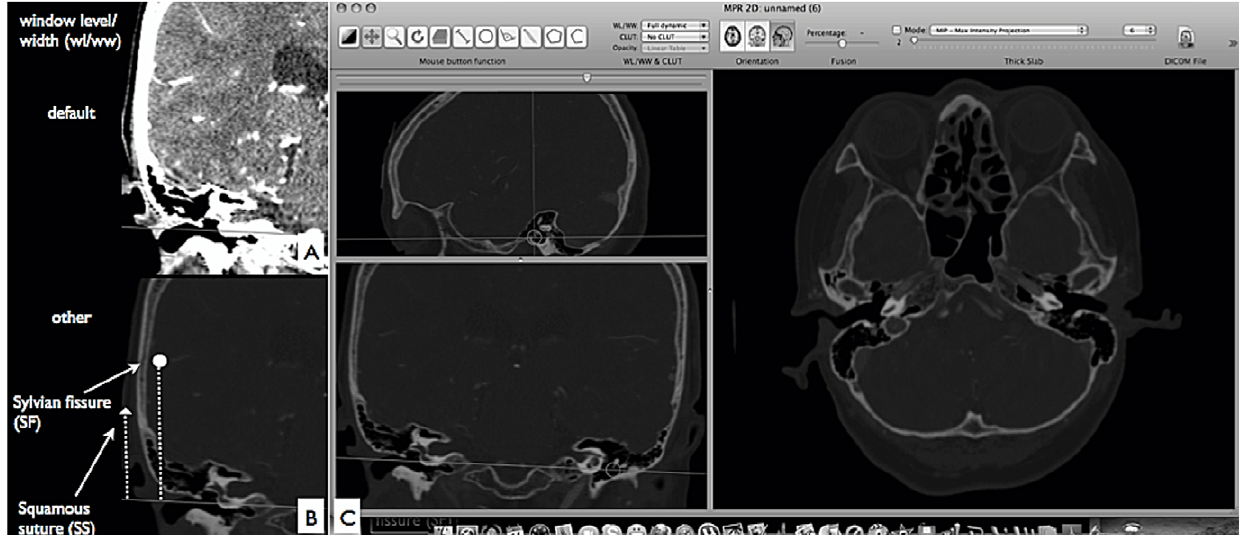
Figure 2. Interface of Osirix DICOM viewer for Sylvian fissure course analysis. a) Coronal view of default window/width level, which can show better visualization of the brain and vessels. b) Coronal bone window view, which can show a better visualization of the SS. White triangle is showing the length of SS, and white dot is showing the length of SF. c) Overall view of 2-D MPR; Crossed lines on sagittal image are movable to desired locations.